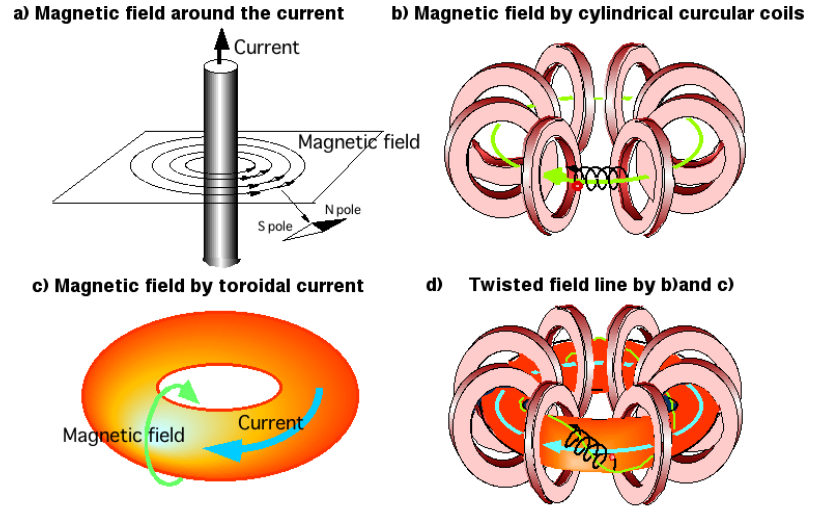
Figure 4. How to create a tokamak configuration: (a) If the current flows, a magnetic field is generated around the current. (b) Arranging circular coils around the torus and energizing the coil produces a magnetic field in the toroidal direction. (c) Toroidal plasma current produces a magnetic field linking the torus. (d) Combination of (b) and (c) creates twisted magnetic field lines and is called a